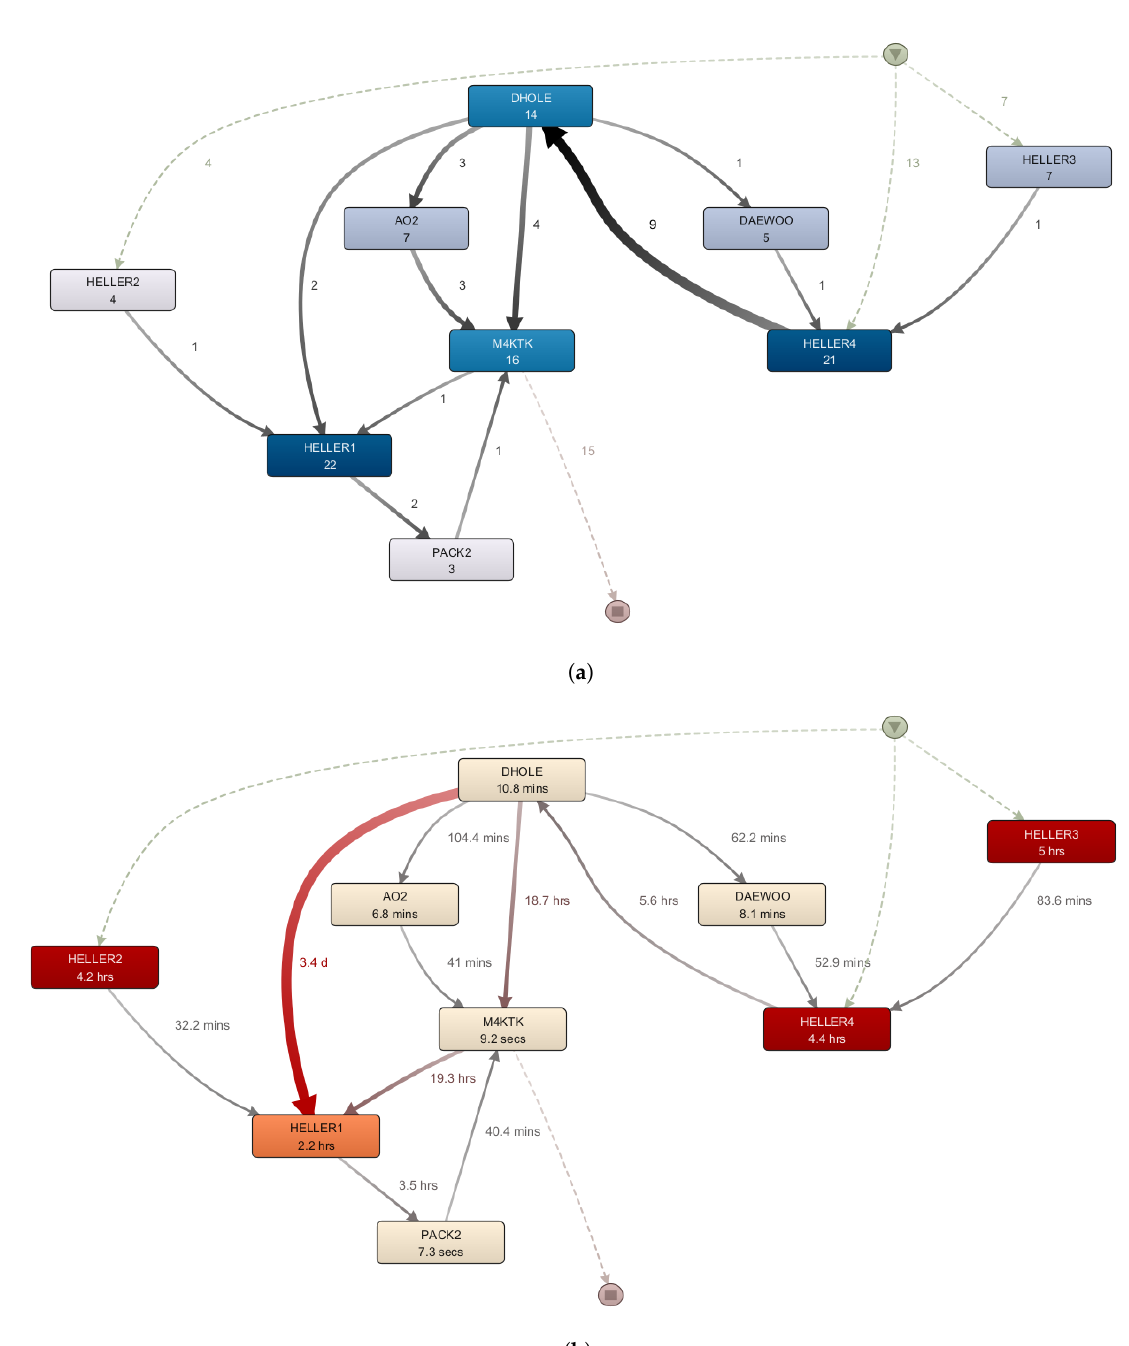
Figure 5. A production flow model discovered by process mining based on IPS and MES data. ( a ) The frequency of the material flows. The colours of stations represent utilisation of the workstations. ( b ) The discovered average cycle and transition times. The colours of stations represent the cycle times. We can notice that the HELLER stations are the bottlenecks of the process. The transition times are represented by the arrows, which highlight the possible hidden